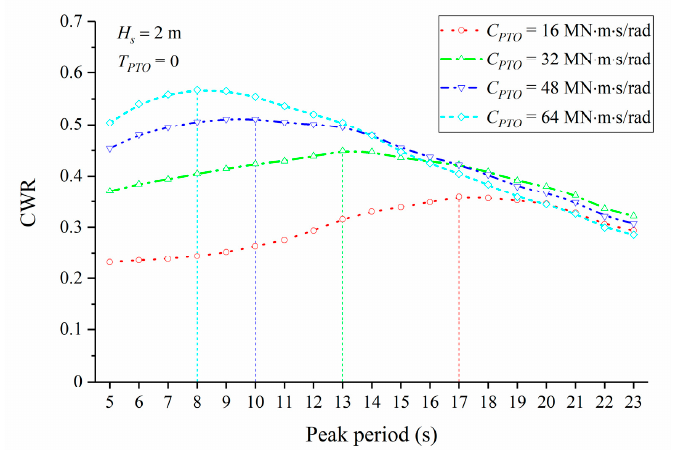
= 0 ) for various values of PTO damping 𝐶 (cid:3017)(cid:3021)(cid:3016) = 2 m in 12.5 m-deep 𝑠